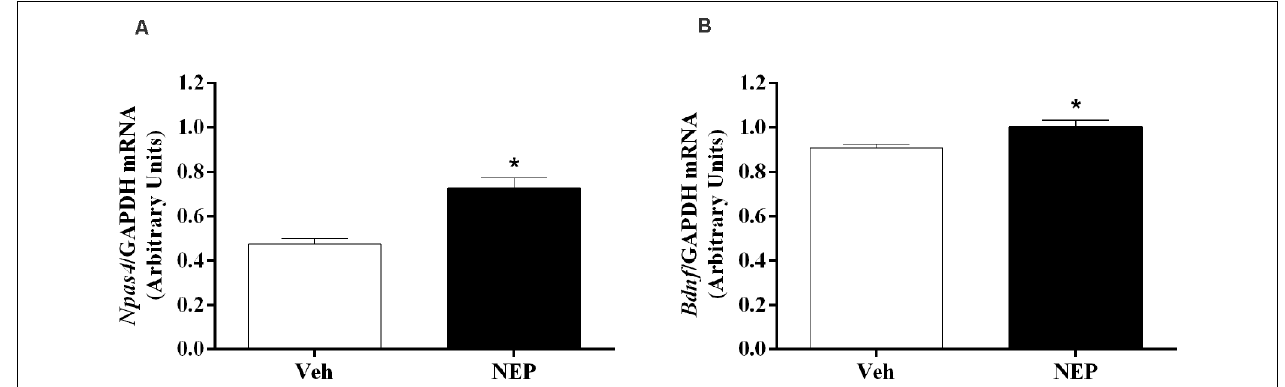
FIGURE 8 | Hippocampus mRNA expression of (A) Npas4 and (B) Bdnf on day 7 of post-traumatic stress disorder (PTSD) induction. Values are means ± SEM of 5–7 mice per group. Results of mRNA are expressed as arbitrary units (AUs) after normalization for Glyceraldehyde 3-phosphate dehydrogenase (GAPDH). Veh, mice in the PTSD-group and treated with vehicle; NEP, mice in the PTSD-group and treated with nepicastat; *, significantly different from correspondent values in mice in the PTSD-group and treated with vehicle ( p <